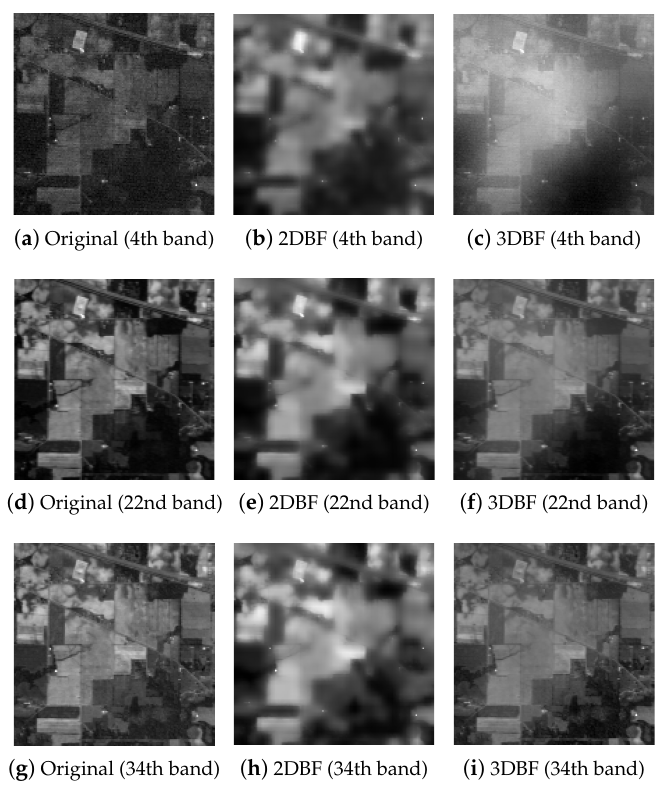
Figure 10. Spatial scenes of the 4th, 22nd, 34th bands. ( a , d , g ) are chosen from the original Indian Pines data, ( b , e , h ) are obtained by the 2DBF, and ( c , f , i ) are obtained by the